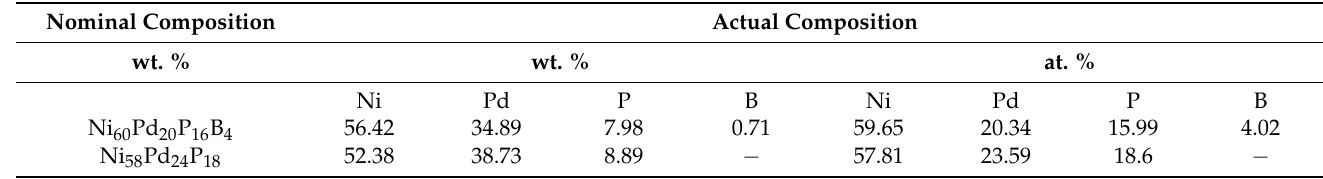
Figure 2. SEM images of the Ni 60 Pd 20 P 16 B 4 glassy alloy ribbon sample before (left) and after electrochemical dealloying (right). Table 1. Nomination and actual composition of the Ni 60 Pd 20 P 16 B 4 alloy before and after electrochemical dealloying.